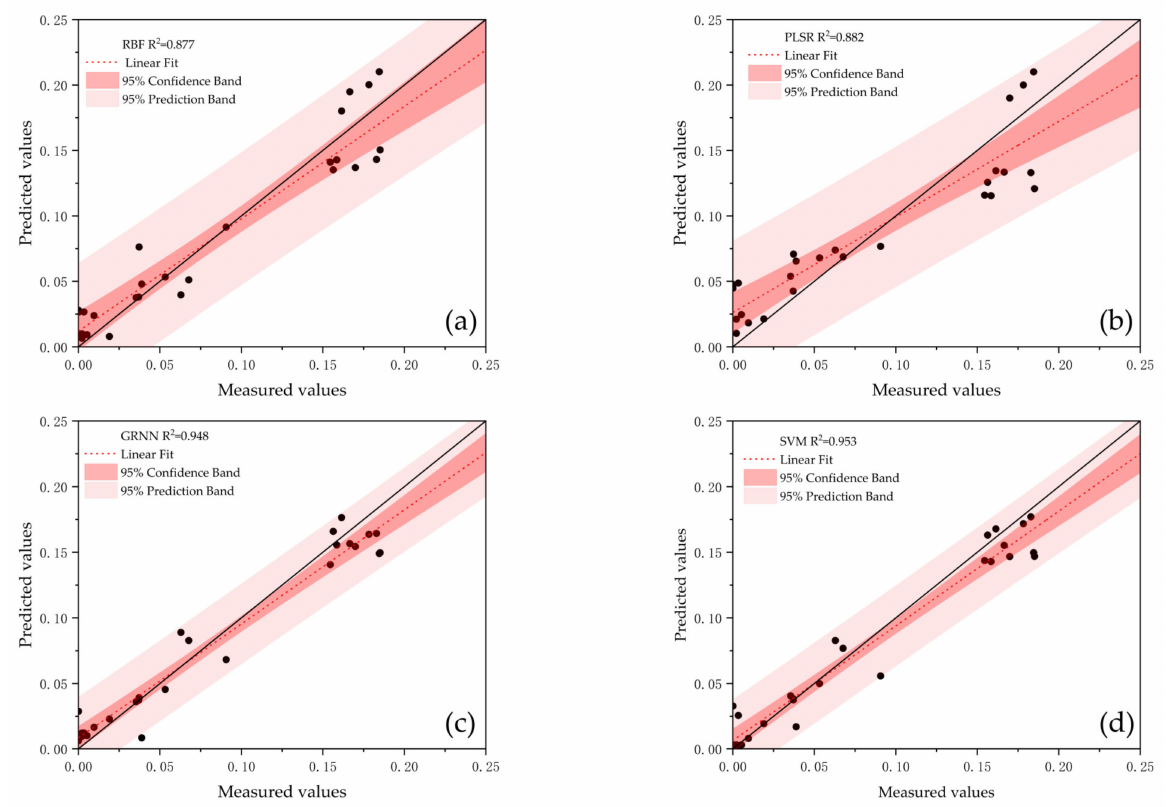
Figure 9. Model prediction of wavelet denoising spectral data ( a ) RBF, ( b ) PLSR, ( c ) GRNN, ( d ) SVM. The measured values and predicted values are expressed as the copper grade of the test samples and the predicted value of the model. The dashed line shows the 1:1 relationship and the black line shows the model trend. The black line shows the 1:1 relationship and the dashed line shows the model trend. In the data augmentation domain, the input spectra with ranges of 450–1700 nm for copper grade were selected to develop multivariate regression models. The SVM model falls within the largest number of points within the 95% confidence